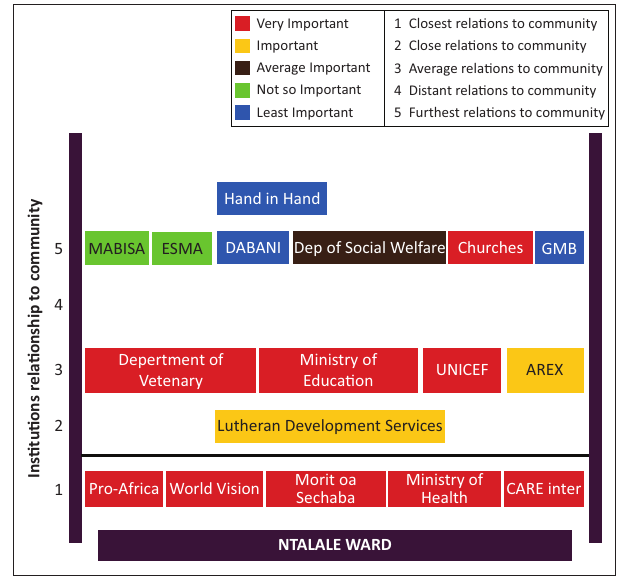
ImportantImportant